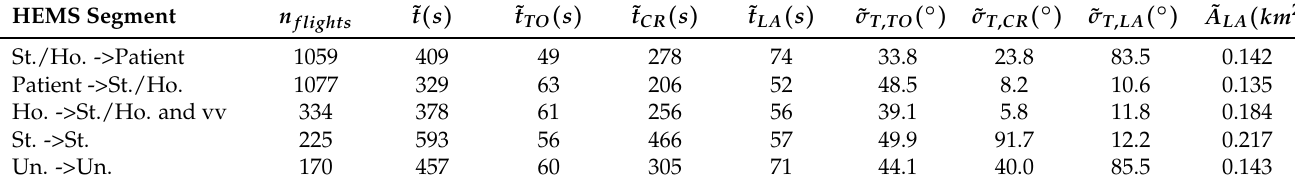
Table 1. Statistics that showed significant differences for HEMS (Station—St., Hospital—Ho., Unknown—Un.) and flight segments (Takeoff—TO, Cruise—CR, Landing—LA): median duration ˜ t , median of the track standard deviation of each flight ˜ σ T and covered landing area A